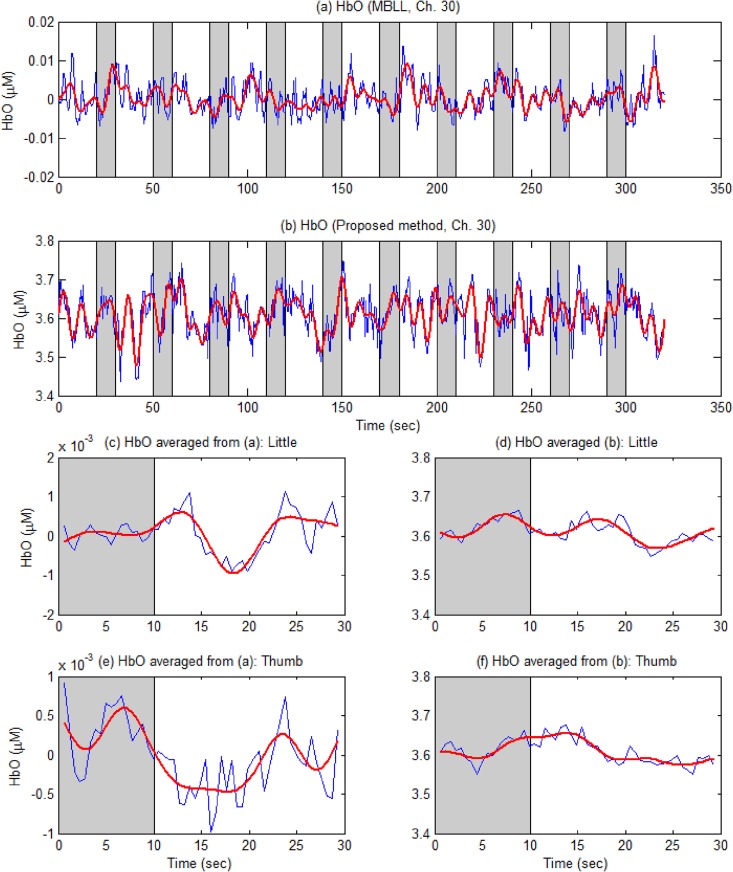
Comparison of two approaches for an inactive channel (Ch. 30, Subject 5).(a) HbOs computed by the MBLL approach (thin blue: raw, thick red: low-pass filtered); (b) HbOs by the proposed method; (c)-(d) the averaged HbO across 5 trials in (a) and (b), respectively, for little finger; (e)-(f) the averaged HbO for thumb finger.